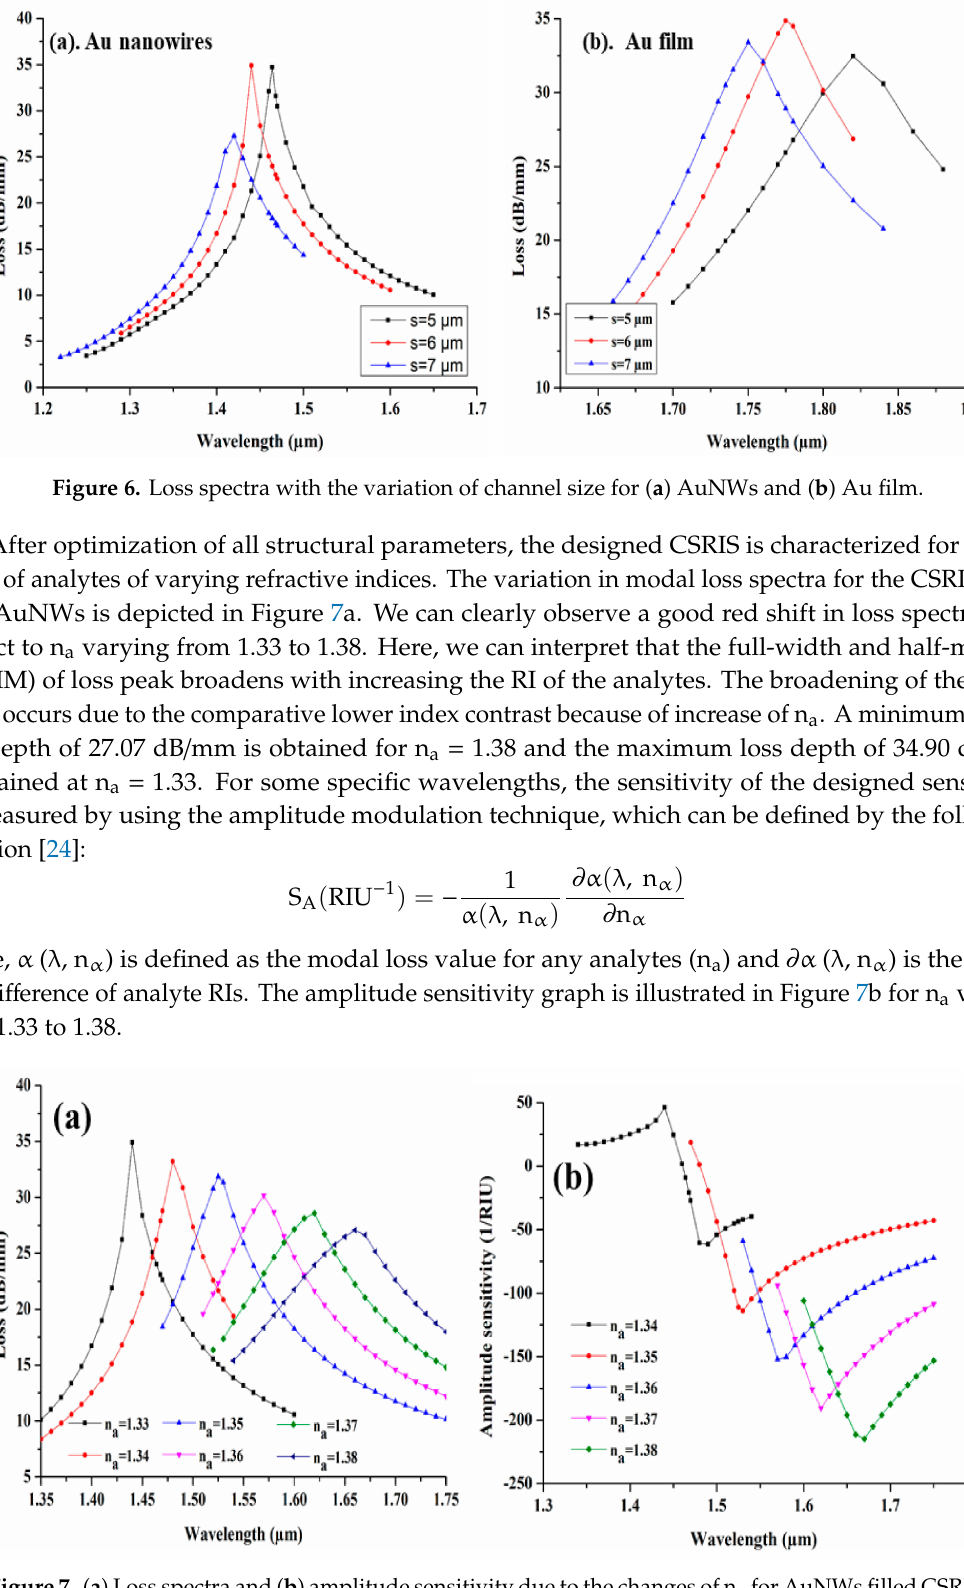
Figure 7. ( a ) Loss spectra and ( b ) amplitude sensitivity due to the changes of n a for AuNWs filled